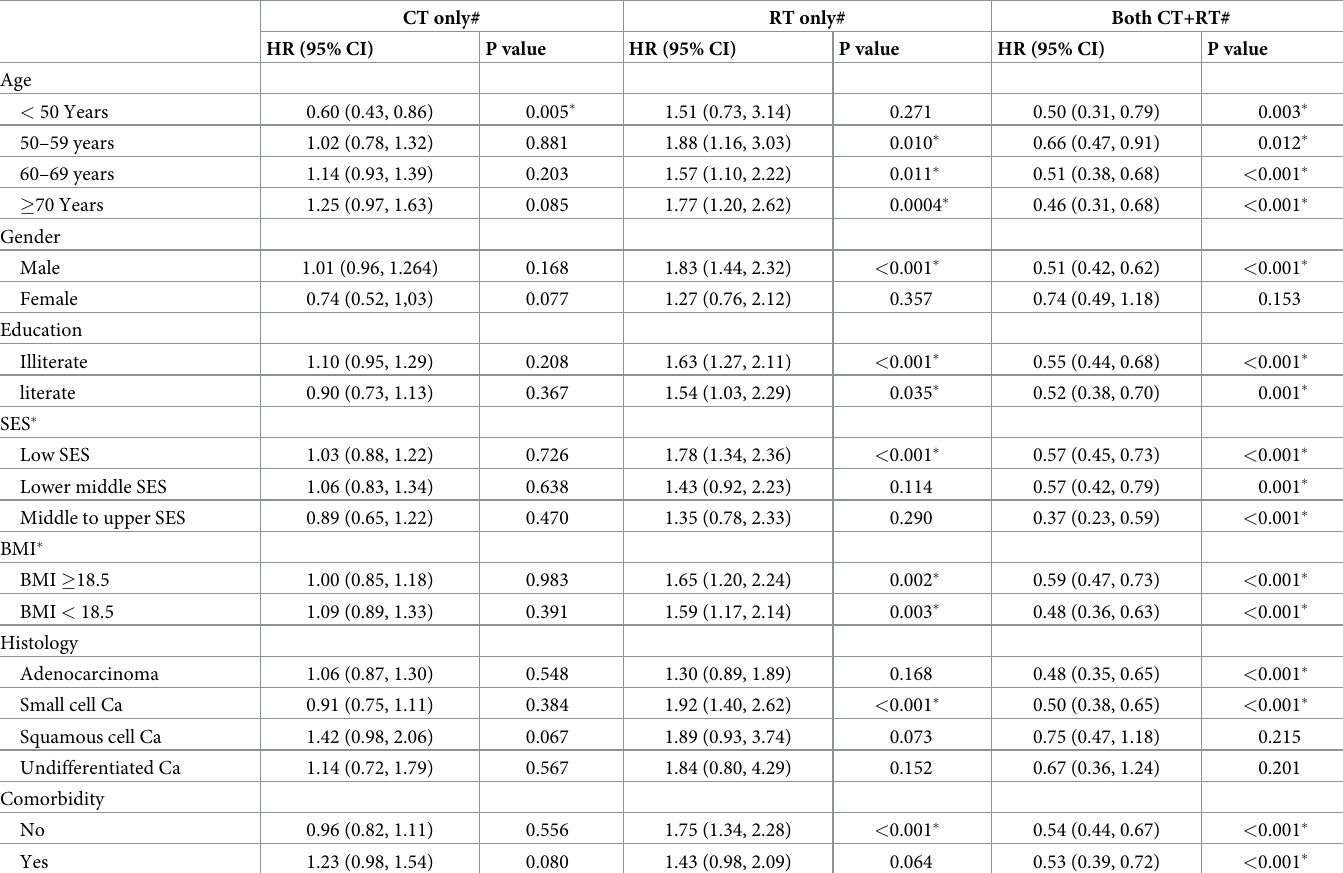
Table 3. Treatment outcome across socio-demographic and disease status